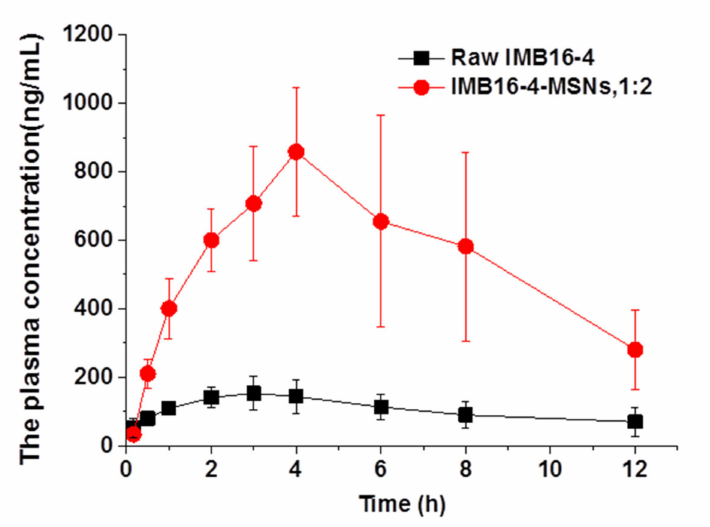
Figure 9. Plasma concentration–time profiles of raw IMB16-4, MSNs and IMB16-4-MSNs (1:2). Results are expressed as the mean with the bar showing SD values of seven rats. Table 2. Pharmacokinetic parameters of raw IMB16-4, MSNs and IMB16-4-MSNs (1:2), mean ± SD, n = 7. Pharmacokinetic